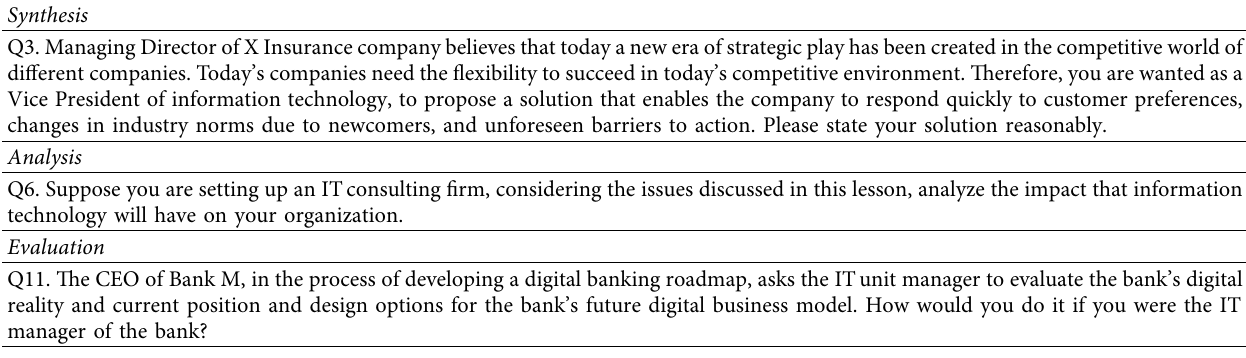
Table 1: Sample questions of the high-level learning outcomes